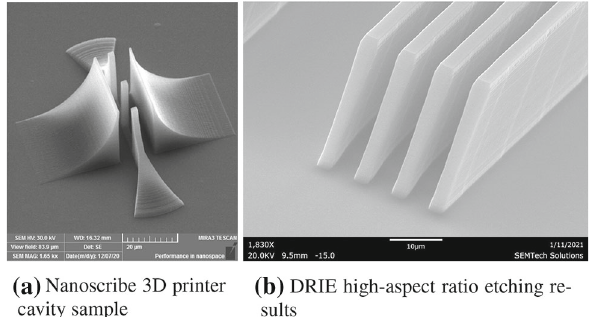
Fig. 2 Initial results from current nanofabrication trian runs: the left panelinthefiguredepictsarecentresultobtainedutilizingaNanoscribe 3D printer to evaluate a range of cavity gaps and pillar sizes; the right panel shows recent etching results using Deep Reactive Ion Etching (DRIE) equipment to etch the high-aspect ratio cavity planes into a silicon wafer